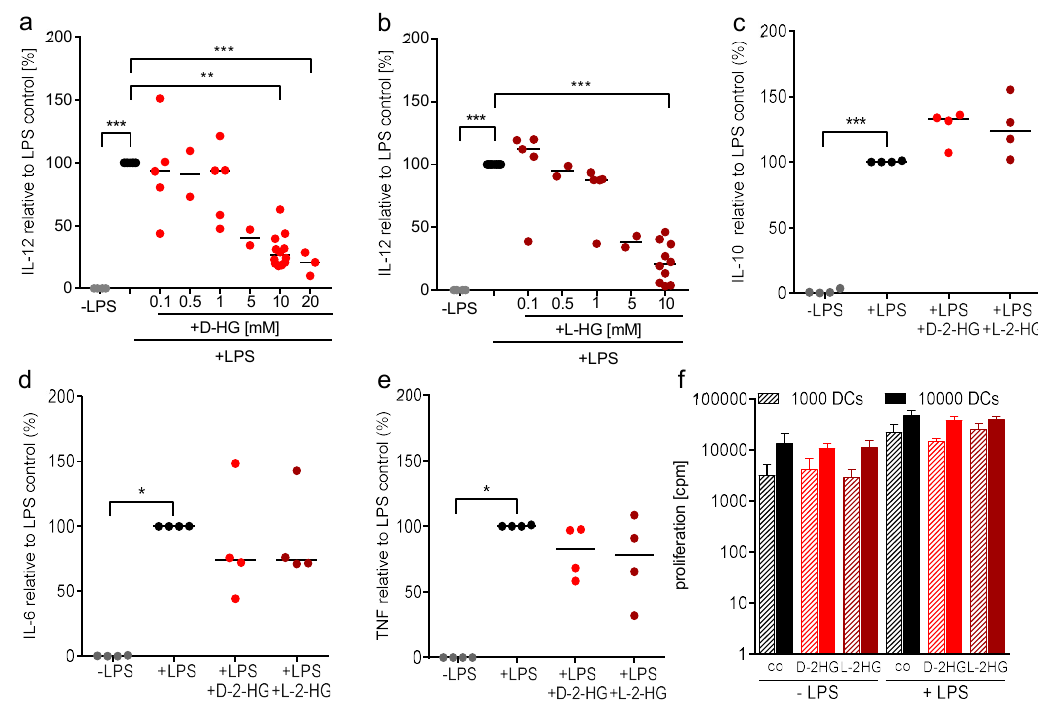
Figure 2. 2-HG modulates LPS-stimulated cytokine secretion by DCs. Monocyte-derived DCs were plated in 6-well plates. DCs were activated with 100 ng/mL LPS and in parallel exposed to D-2-HG or L-2-HG for 24 h. Supernatants were collected and measured for IL-12 ( a , b ), IL-10 ( c ), IL-6 ( d ), and TNF ( e ). The measurements were performed by commercially available ELISA’s. Data represent the median of four independent experiments. Statistical analysis was tested using Dunnet’s multiple comparison test (* p ≤ 0.05, ** p ≤ 0.01, *** p ≤ 0.001). ( f ) Antigen presentation was analyzed in a mixed lymphocyte reaction. DCs were cultured in flasks in the absence or presence of LPS and 2-HG for 24 h, harvested, and cocultured with allogeneic T cells for another five days. Proliferation was determined by [3H]-thymidine incorporation.